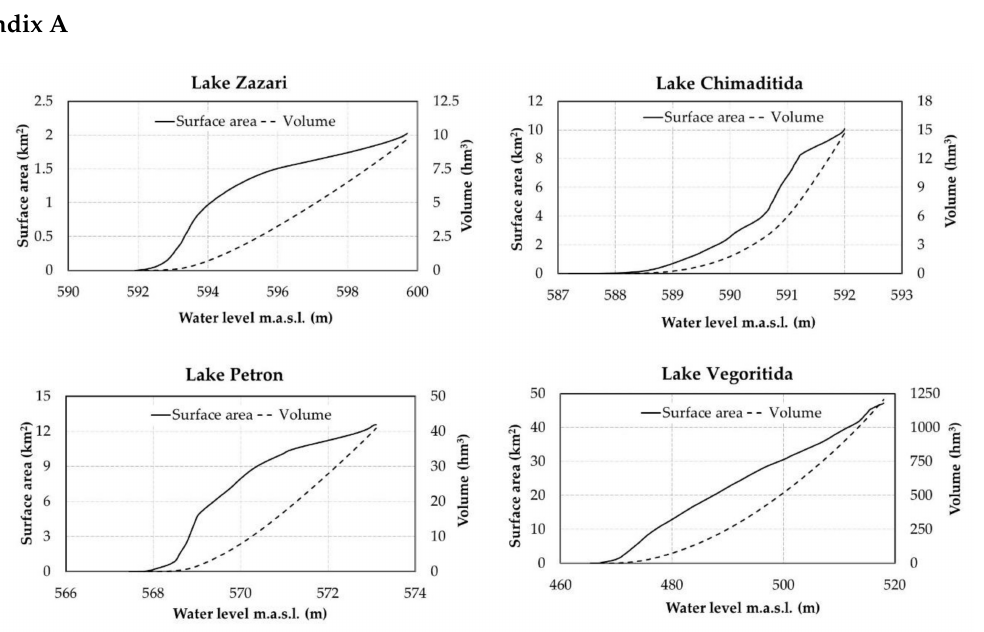
FigureA1. Waterlevelsurfacearea–volumecurvesofLakesZazari, Chimaditida, Petron, andVegoritida. Table A1. The literature used for the determination of water depth preferences of macrophyte plant indicator